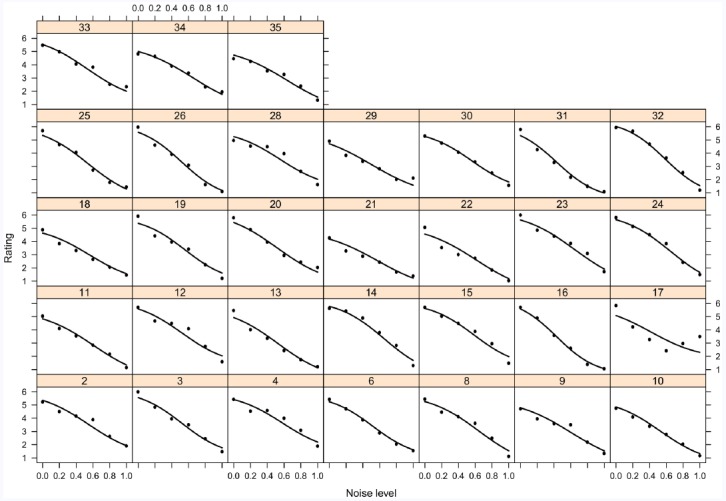
Figure A2. Sense of control rating plotted as functions of noise level for each participant. Four-parameter sigmoid functions were fitted to the data.